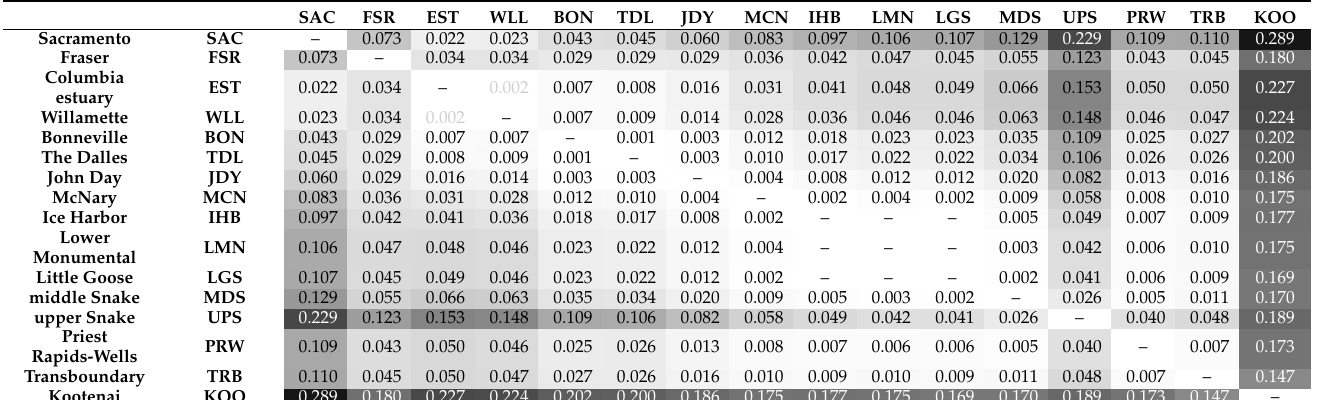
Table 2. Rates of population assignment of white sturgeon by reach, with source listed vertically and assigned reach horizontally. On-diagonal elements reflect the proportion of fish assign back to source reach. Off-diagonal elements reflect the proportion of fish that were assigned from the reach indicated by the row name to the reach indicated by the column heading. Sample size for each reach is indicated in the third column.